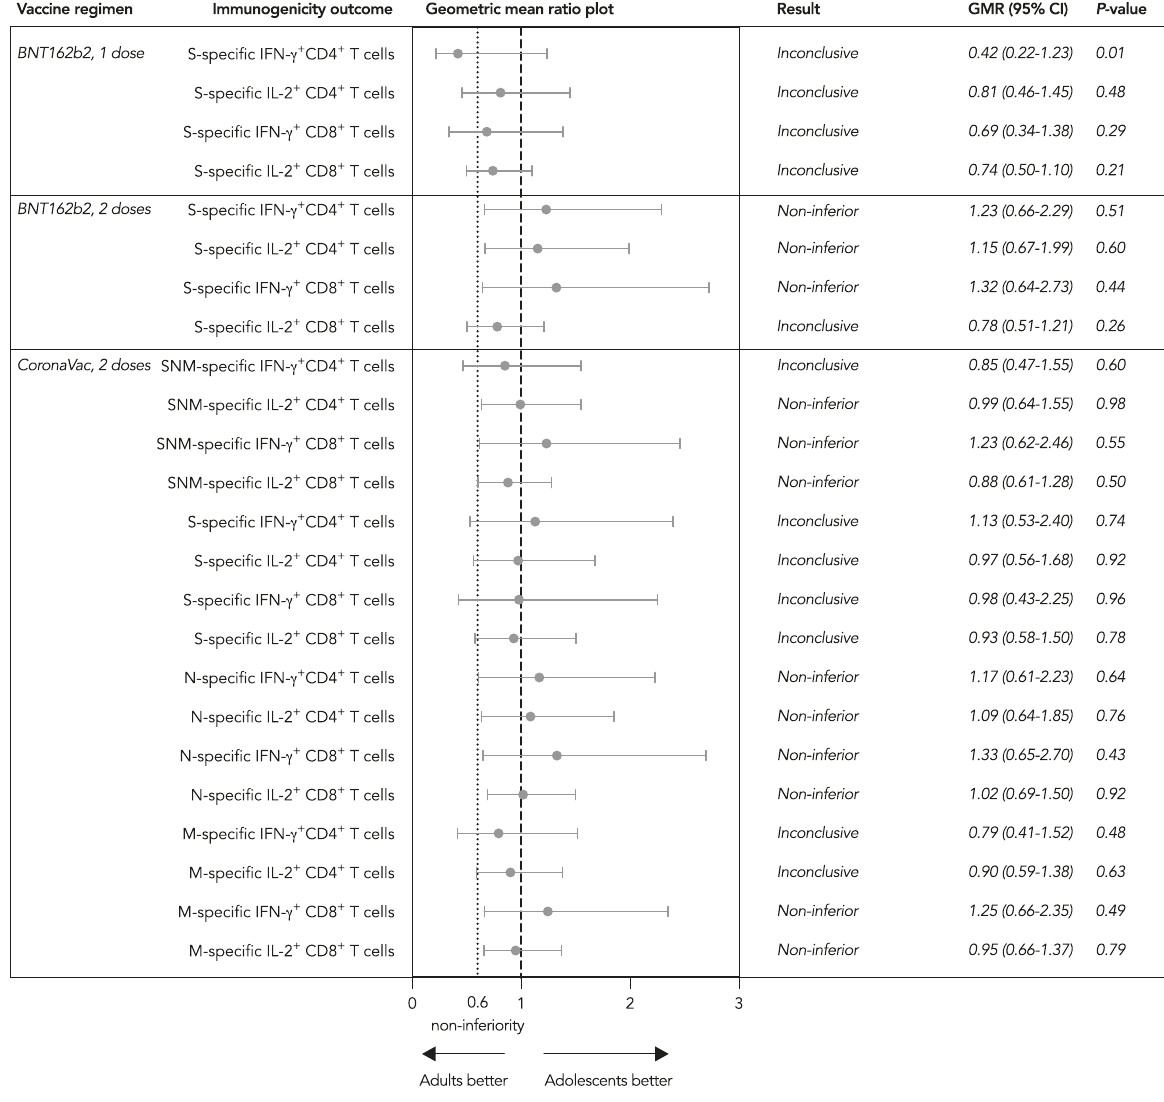
Fig. 2 Cellular immunogenicity outcomes for adolescents were mostly non-inferior or inconclusive in adolescents in comparison to adults. a , b Adolescents receiving one dose of BNT162b2 (B; N = 58) and 2 doses of BNT162b2 (BB; N = 56) and c adolescents receiving 2 doses of CoronaVac (CC; N = 60) were tested for IFN- γ + and IL-2 + CD4 + and CD8 + T cells on fl ow-cytometry-based intracellular cytokine staining assays speci fi c to S (and N and M for CC) for 21 days after dose 1 and 28 days after dose 2. The results of SNM-speci fi c T cell responses were calculated from the sum of responses of the individual S, N and M peptide pools. S-speci fi c IFN- γ + CD4 + , IL-2 + CD4 + and IFN- γ + CD8 + T cell responses were non-inferior for adolescent BB in comparison to adults ( N = 47). For adolescent CC compared to adults ( N = 36), SNM-speci fi c IL-2 + CD4 + , IFN- γ + CD8 + and IL-2 + CD8 + , N-speci fi c IFN- γ + CD4 + , IL-2 + CD4 + , IFN- γ + CD8 + and IL-2 + CD8 + , M-speci fi c IFN- γ + CD8 + and IL-2 + CD8 + were non-inferior. The remaining cellular immunogenicity outcomes were inconclusive. Dots and error bars show GMR estimates and two-sided 95% CI respectively. GMR geometric mean ratio, CI con fi dence interval, S spike protein, N nucleocapsid protein, M membrane protein, IFN- γ interferon- γ , IL-2